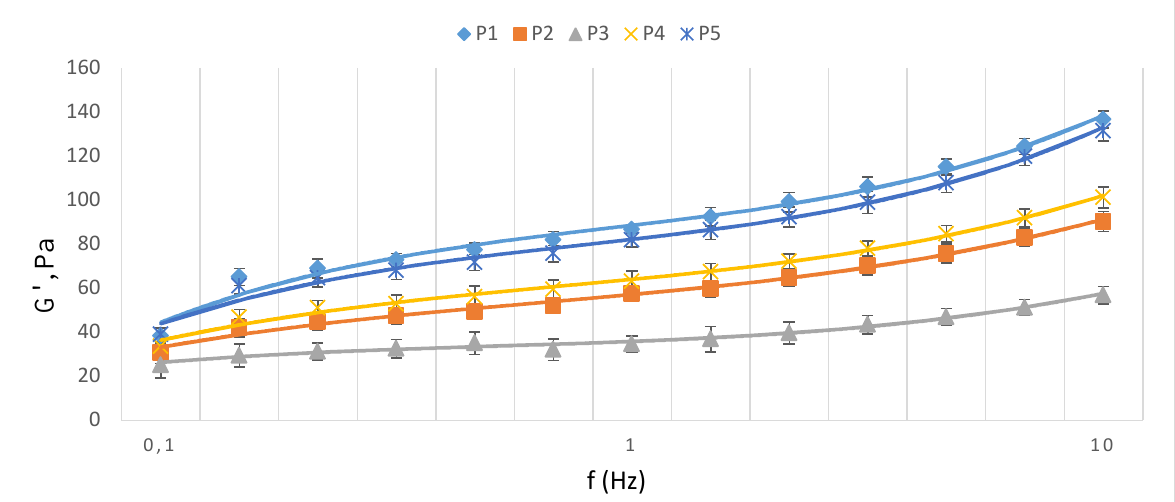
Figure 3. Viscoelastic parameters (G '' ) from frequency of yogurts, series